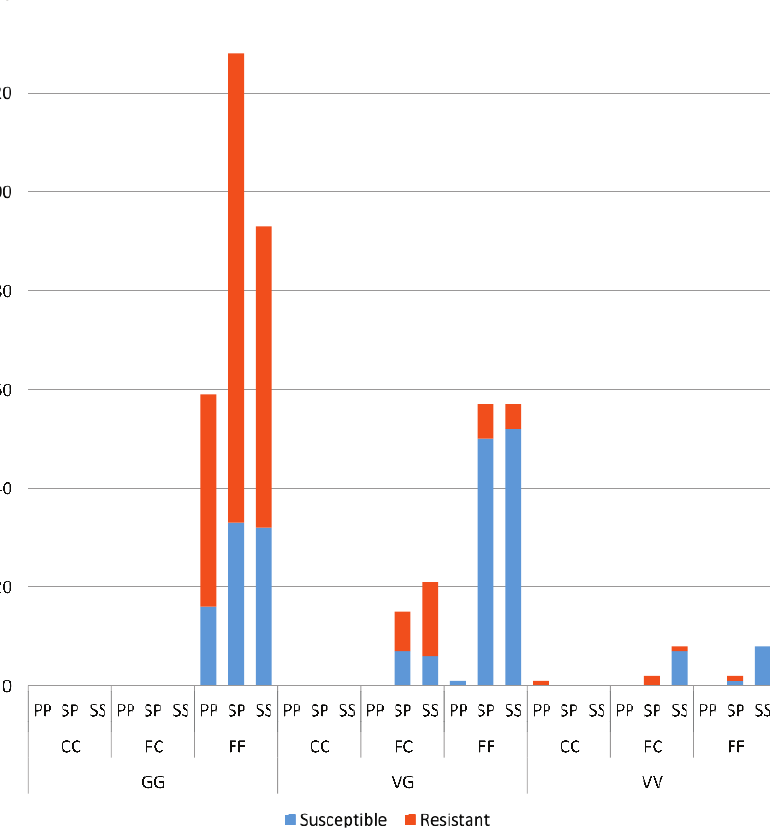
Figure A2. Genotypes of Vssc mutations V1023G, F1565C and S996P in order in individual Aedes aegypti from bioassay samples, Yogyakarta, Indonesia.